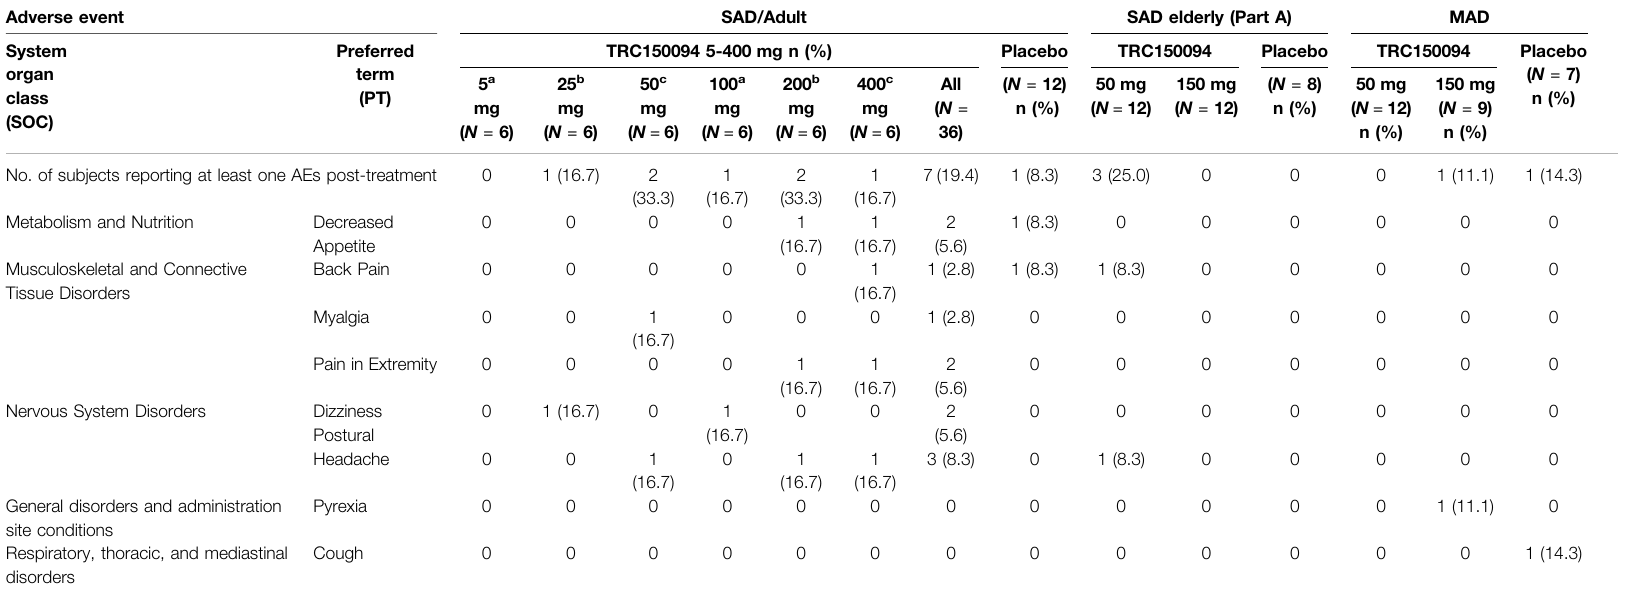
TABLE 3 | Summary of adverse